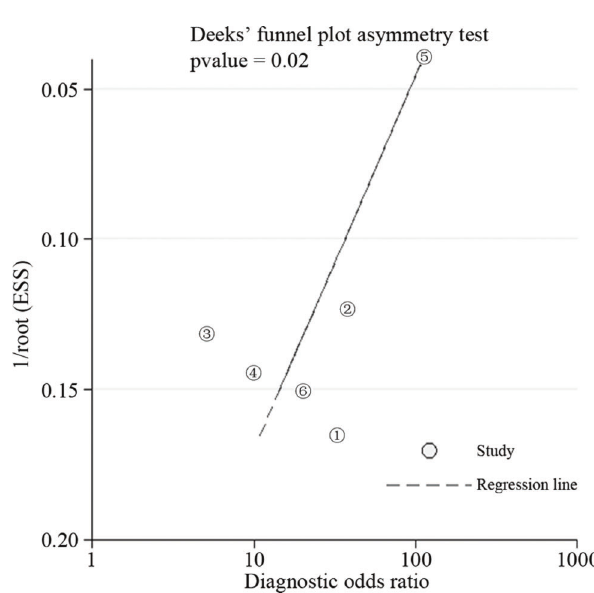
Figure 6 - Deeks funnel plot for the evaluation of publication